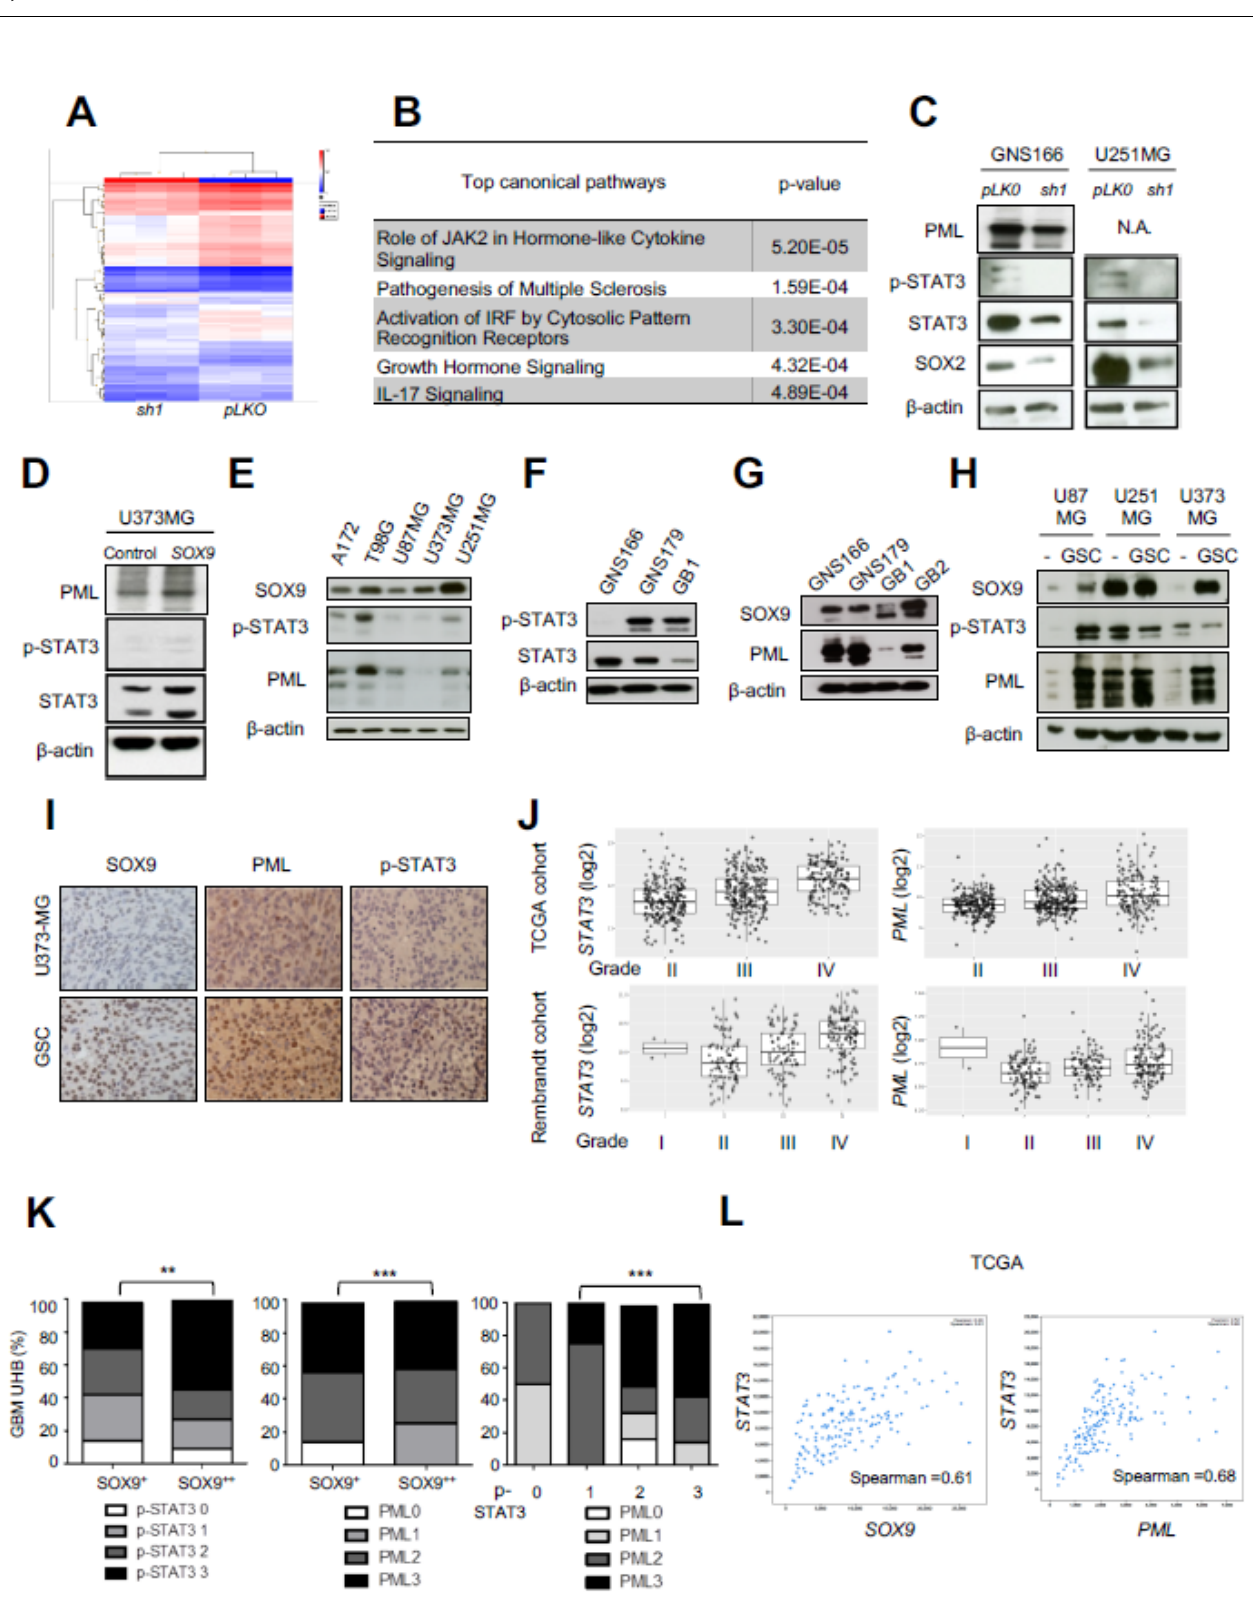
Figure 4. SOX9 expression correlates with STAT3 and PML: ( A ) cluster analysis of GNS166 cells after transcriptomic analysis; ( B ) top canonical pathways altered in shSOX9 (sh1) GNS166 cells compared to controls ( n = 3); ( C ) representative immunoblots of PML, p-STAT3, STAT3 and SOX2 expression in sh1 and pLKO GNS166 and U251-MG cells ( n = 3); ( D ) representative immunoblot of PML, p-STAT3, and STAT3 expression in SOX9 and control U373-MG cells ( n = 3); ( E ) representative immunoblot of SOX9, p-STAT3, and PML expression in indicated glioma cell lines ( n = 3); ( F ) repre- sentative immunoblot of p-STAT3 and STAT3 expression in GNS166, GNS179, and GB1 patient- derived glioma stem cells; ( G ) representative immunoblot of SOX9 and PML protein levels in